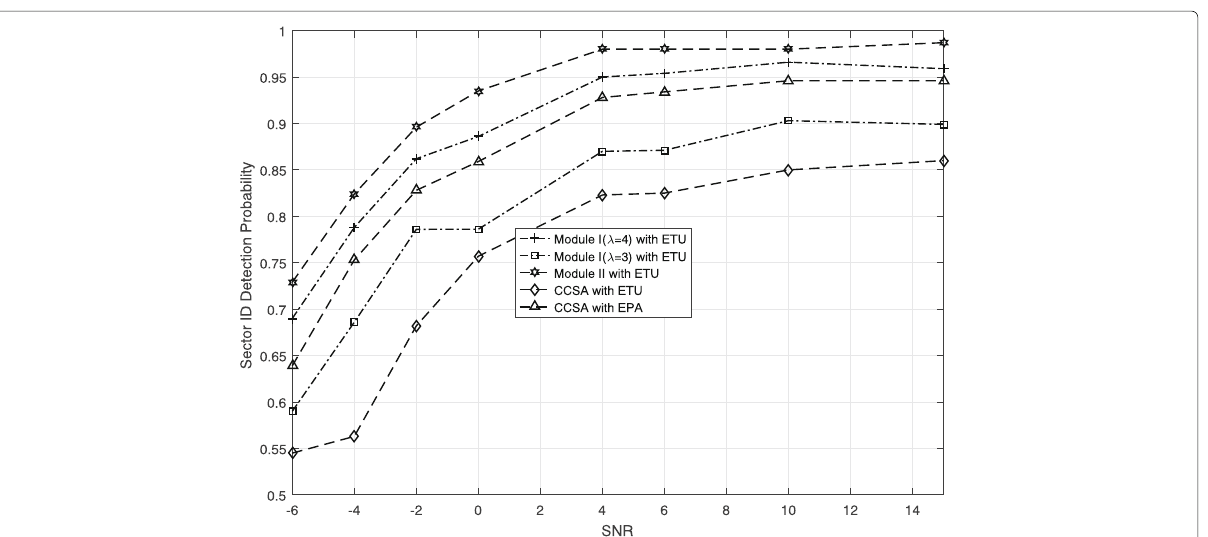
Fig. 4 SID detection probability using CCSA